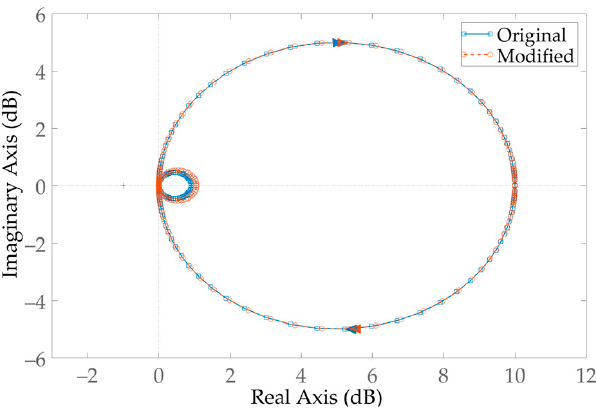
Figure 13. A Nyquist stability comparison between the original and modified designs.